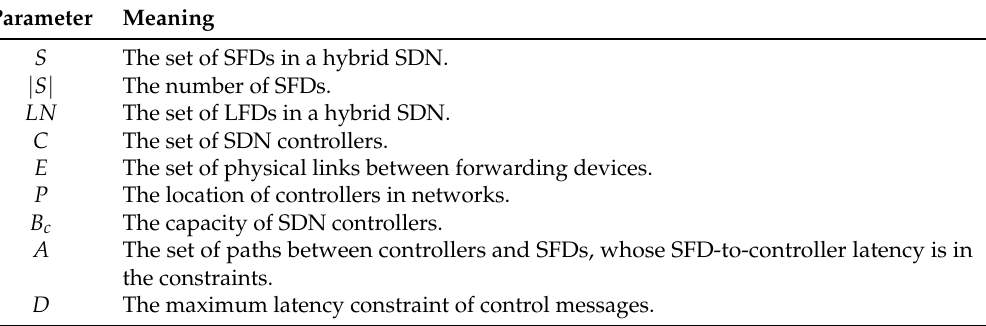
Table 1. List of notations used. SFDs: SDN-enabled Forwarding Devices. SDN: Software-defined networking. LFDs: Legacy Forwarding